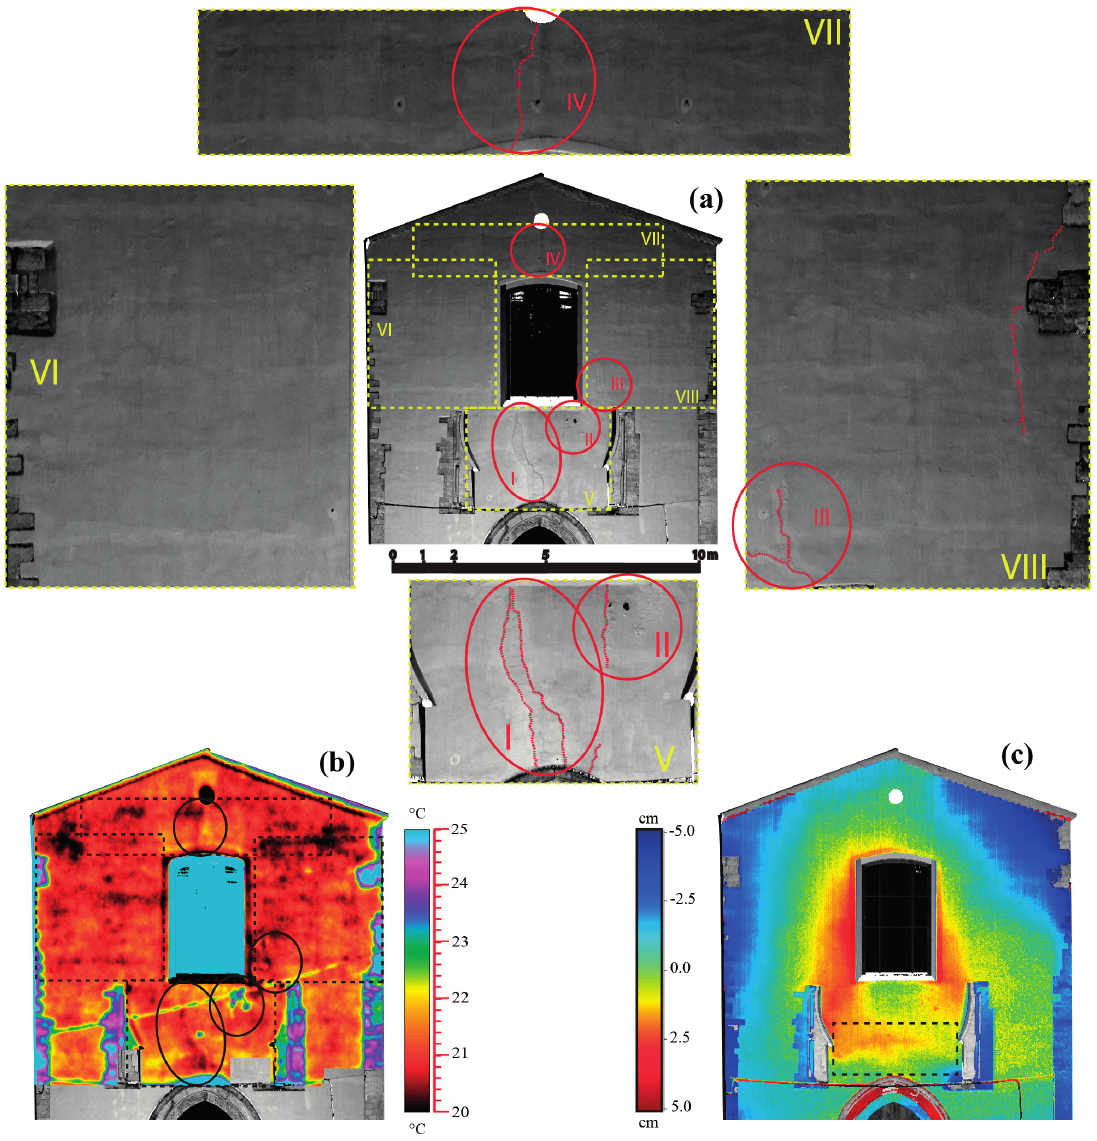
Figure 5. Comparison between terrestrial laser scanning and thermographic survey on the façade of the St. Augustine church: ( a ) 3D mesh obtained by the point cloud in terms of reflectance and details; ( b ) thermal image projected over the mesh and ( c ) map of residuals with respect to a fitting